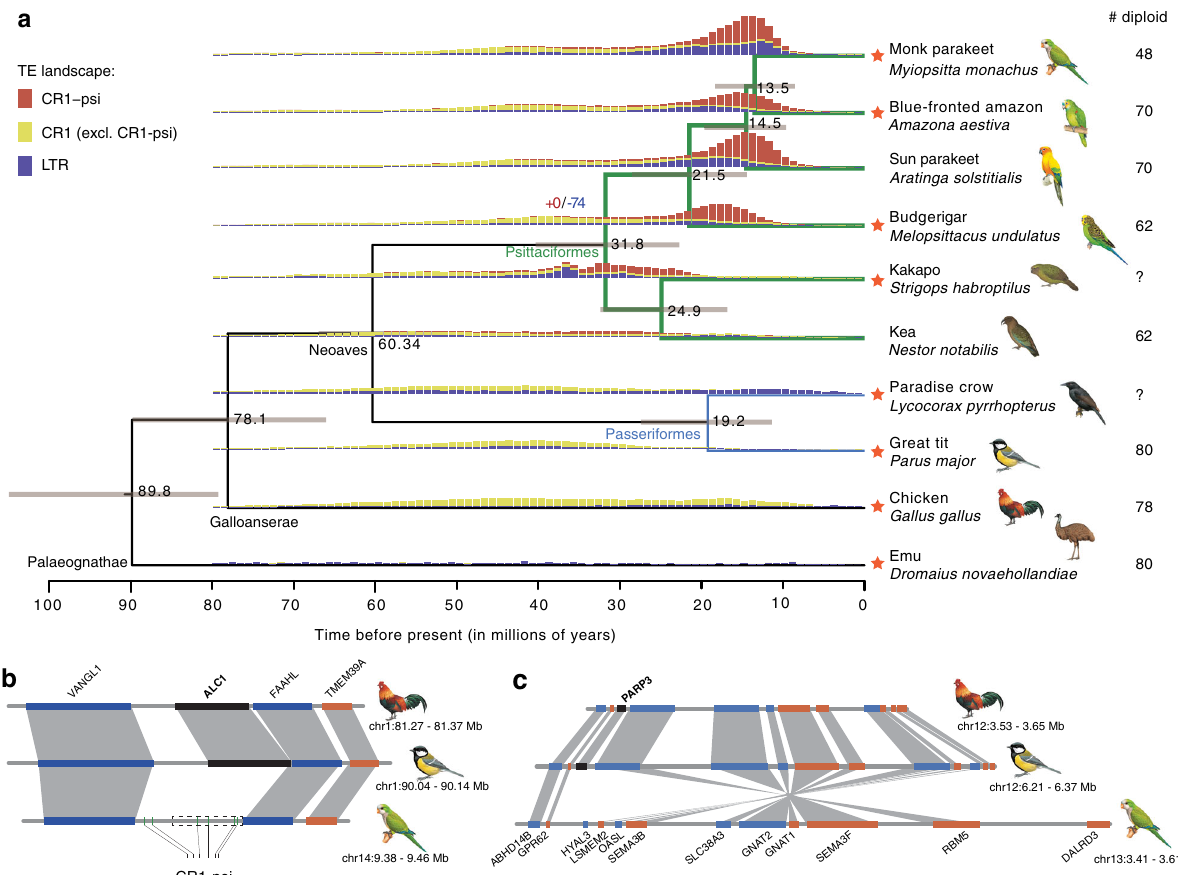
Fig. 1 Phylogeny and comparative genomics of parrots. a The phylogeny of nine bird species shows the divergence time (denoted at the nodes) calibrated with fossil records at the node Psittacopasserae (51.81 – 66.5 My) and Strigopoidea (15.9 – 66.5 My). The orange asterisks to the left of species names indicate the availability of chromosome-level assemblies. The numbers of gene gains (0, in red) and losses (74, in blue) were denoted at the Psittaciformes node. The vertical bars show the frequency of TE (LTR and CR1) insertions during the evolution of bird species (see details in “ Methods ” ). CR1 is divided into CR1-psi and the other CR1. CR1-psi originated in parrots and continued to propagate in parrot lineages. The numbers of diploid chromosomes are listed in the right panel that shows greater variation in parrots. b , c The loss of ALC1 and PARP3 (highlighted in black) in parrots. Monk parakeet is used to represent the parrot lineage. The synteny of genes around ALC1 and PARP3 is illustrated by gray bands connecting orthologs across species. ALC1 was pseudogenized (indicated by dashed rectangle) due to multiple exon losses (Supplementary Fig. S6). Multiple copies of CR1-psi have been inserted at the ALC1 locus. Parrots have evolved an inversion around the PARP3 locus and inversion breakpoint co-localize with PARP3 . Illustrations reproduced by permission of Lynx